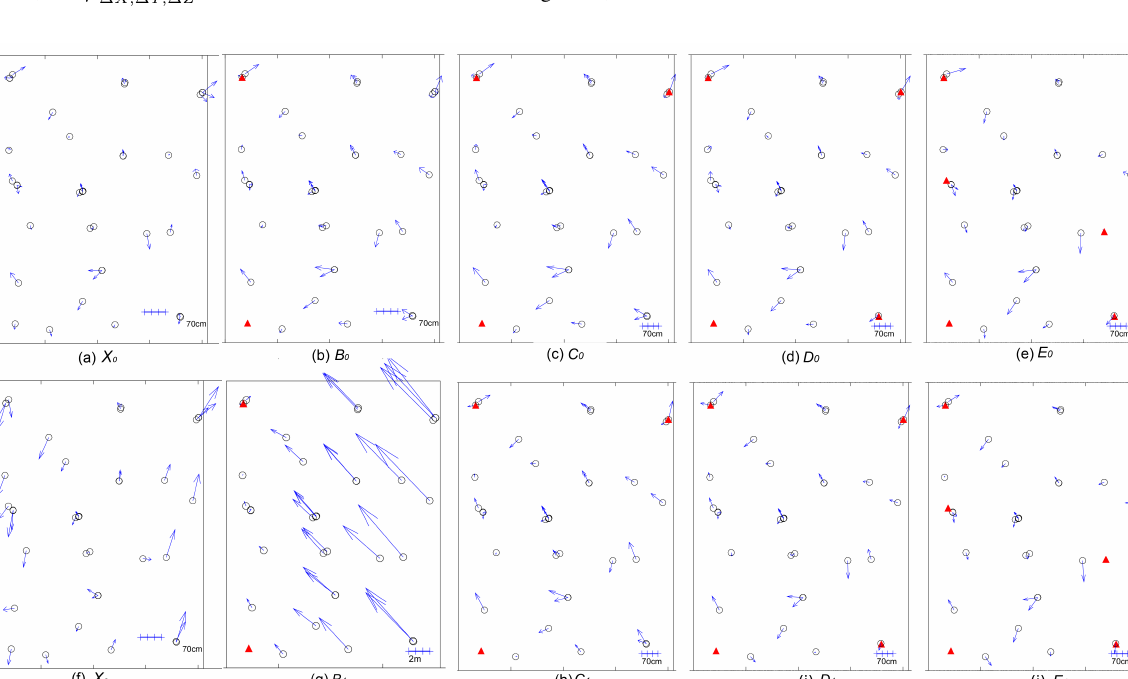
Table 2: Limoge; σ 0 – bundle adjustment standard deviation, µ gt – mean discrepancies between BA-estimated and true values ∆ X, ∆ Y, ∆ Z on GCPs, and µ cp – on CPs. The Y-coordinate runs along-track, the X-coordinate runs across-track. ∆ X, ∆ Y, ∆ Z